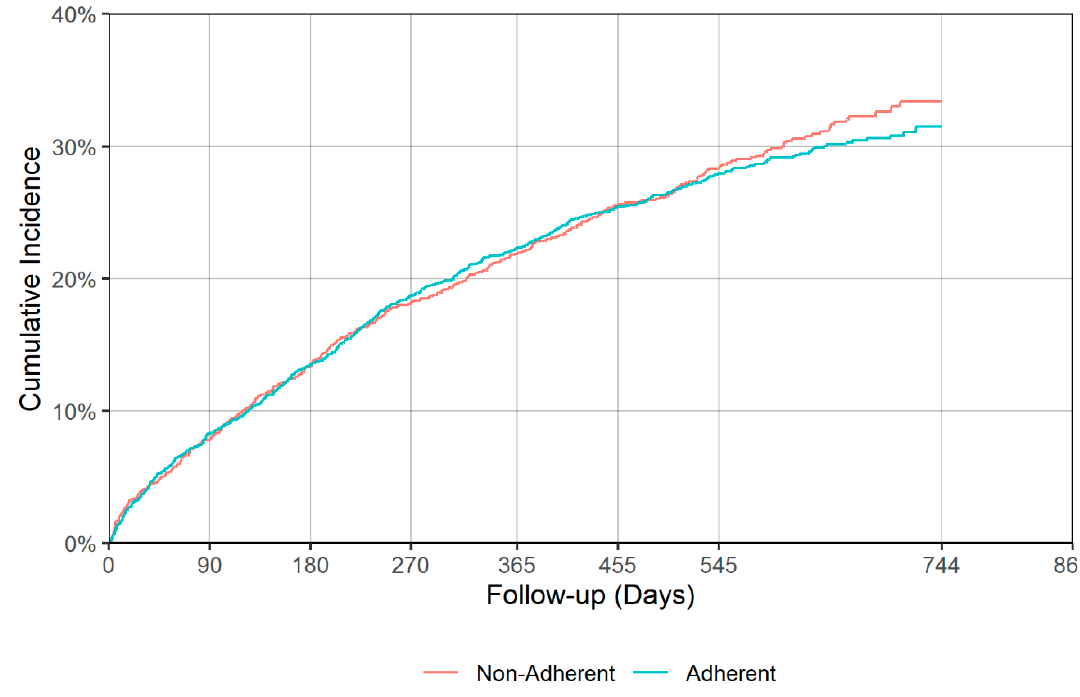
Figure 7. IPT-weighted cumulative incidence function of falls / fractures, adjusting for death before hospitalization as a competing risk (acute phase). Modified Gray’s test p = 0.318.